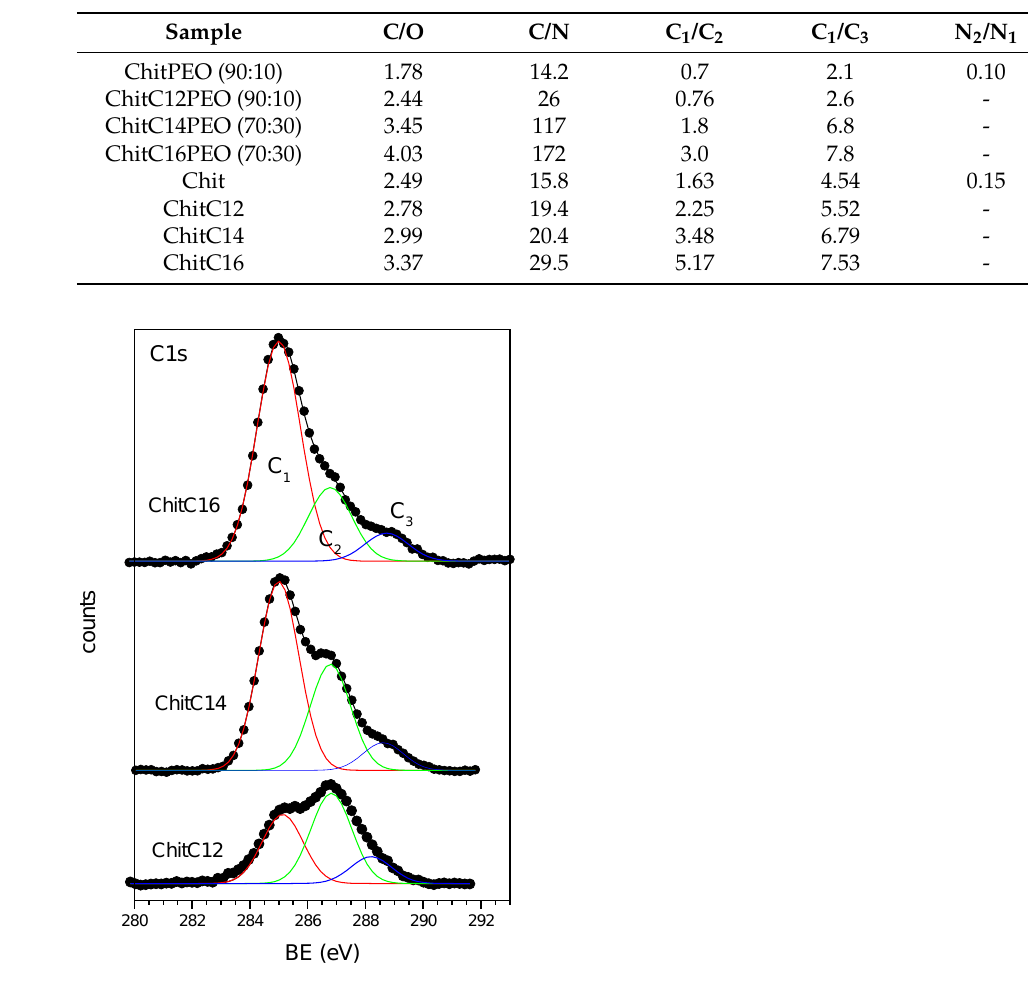
Table 1. Atomic ratios for electrospun scaffolds and reference samples.